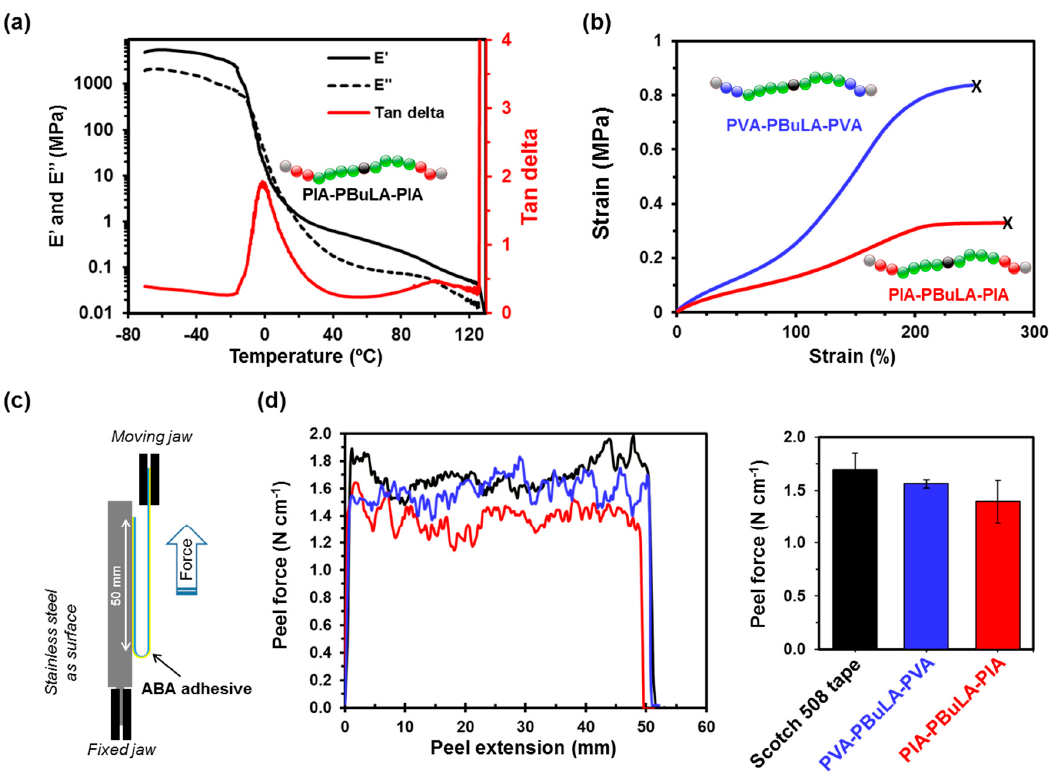
Figure 9. ( a ) Dynamic tensile storage (E’) and loss (E’’) moduli and tan ( δ = E’’/E’) as a function of temperature of PIA-PBuLA-PIA triblock; ( b ) stress-strain curves of PIA-PBuLA-PIA and PVA-PBuLA-PVA; ( c ) schematic design of 180° peel test; and ( d ) 180° peel force of PIA-PBuLA-PIA, PVA-PBuLA-PVA and Scotch 508 tape.